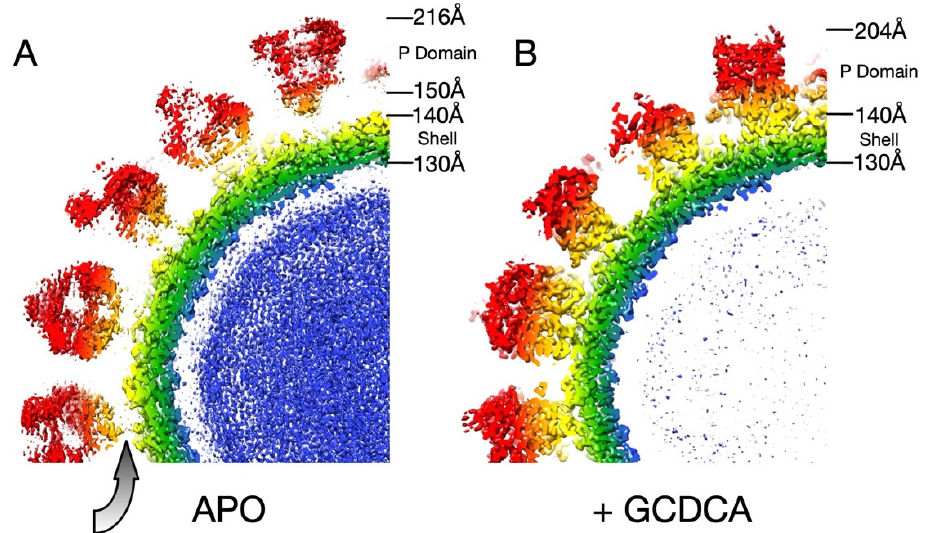
Figure 2. Cross sections of MNV-1 at pH 7.5 in the absence and presence of GCDCA [11]. Shown here are the central sections of the cryo-EM image reconstructions of MNV-1 in the absence ( A ) and presence ( B ) of GCDCA. The density surfaces are colored according to the distance from the center of the particle. Note that the P domain in the apo structure is more diffuse, suggesting mobility, and is >15 Å above the shell surface compared to the structure in the presence of GCDCA. The contracted structure observed in the presence of GCDCA was essentially identical to MNV-1 at pH 5.0 [20].